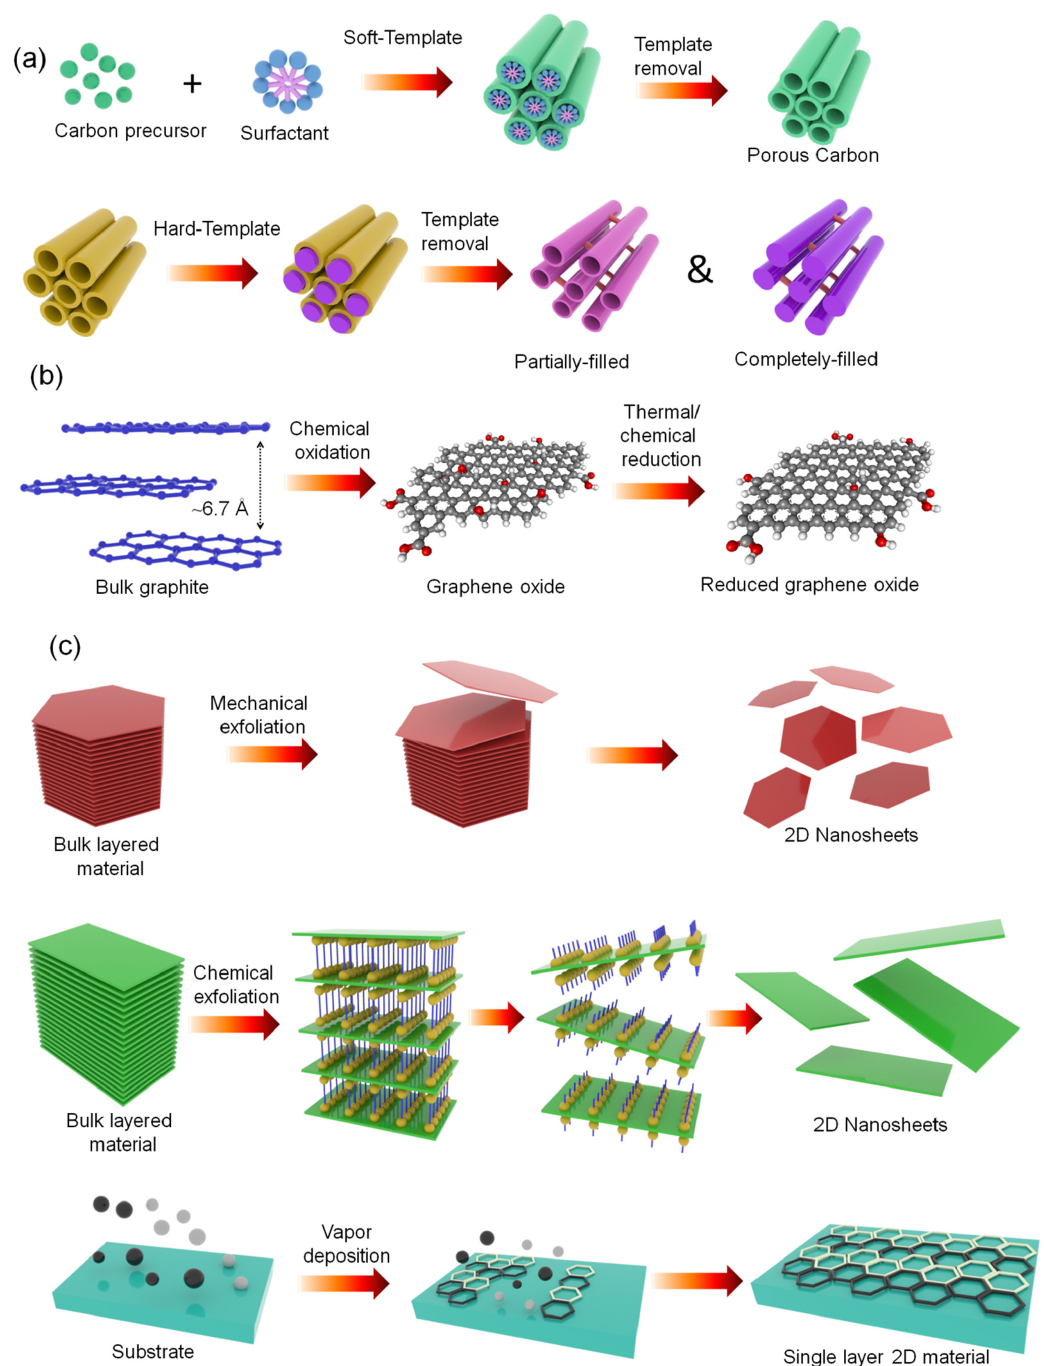
Figure 2. Various synthetic strategies of ( a ) activated carbon, ( b ) reduced graphene oxide, and ( c ) 2D layered materials.